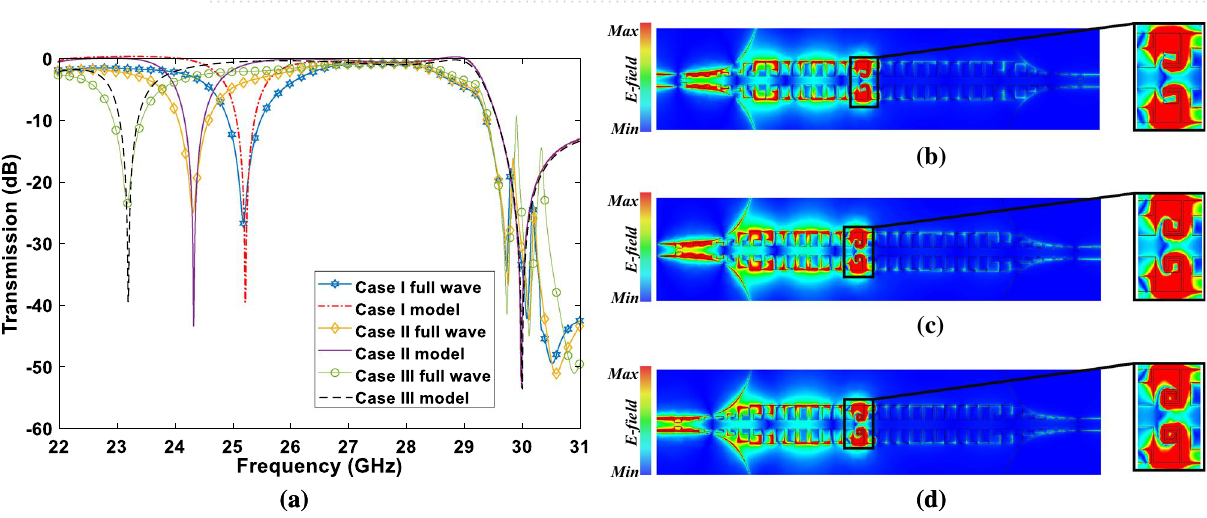
Figure 6. Results of SSPPs TL loaded by stub resonator. ( a ) Transmission coefficient obtained from the proposed model compared with the full wave simulations. Electric field distribution of the filter at ( b ) 25.2 GHz, ( c ) 24.3, ( d ) 23.2 GHz. Keysight 2021 (https:// www. cmc. ca/ keysi ght- pathw ave- cmc- 00200- 00872/) software and MATLAB 2021 (https:// www. mathw orks. com/ produ cts/ matlab. html) were used to generate this